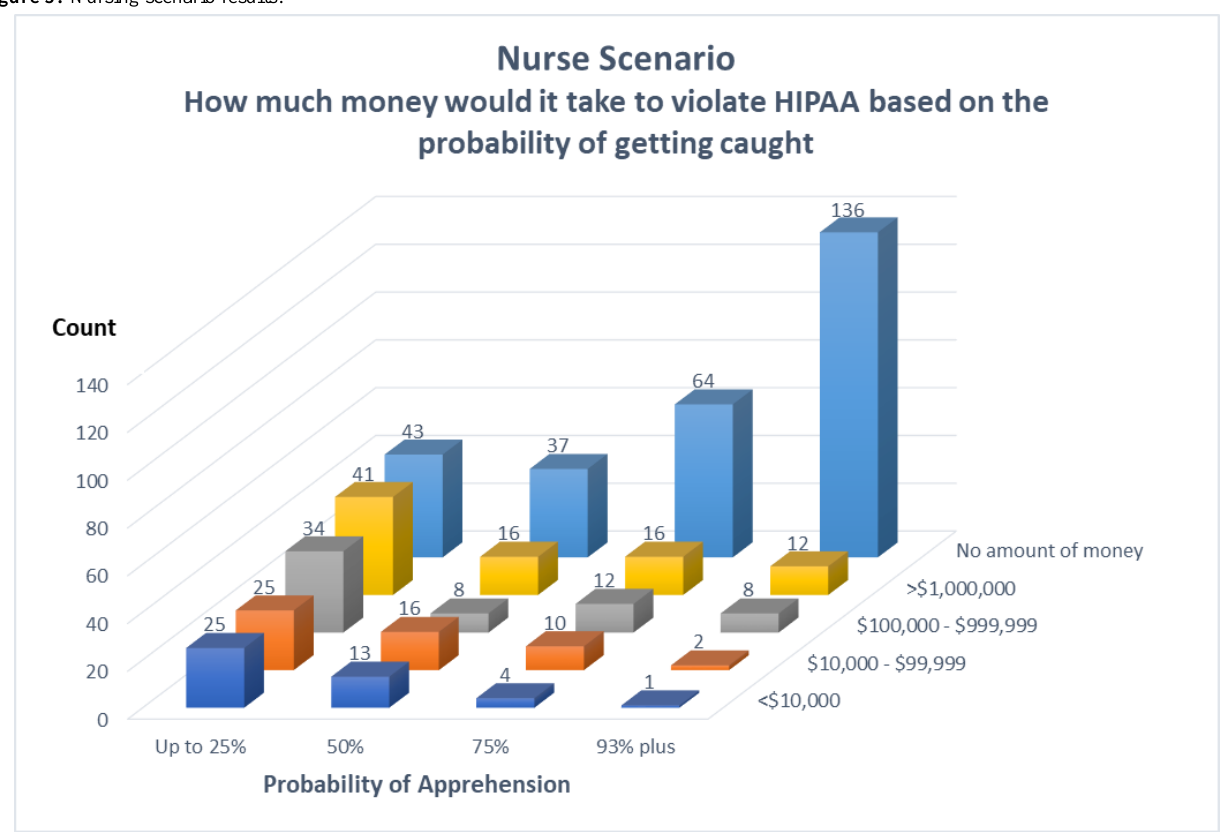
Figure 3. Nursing scenario